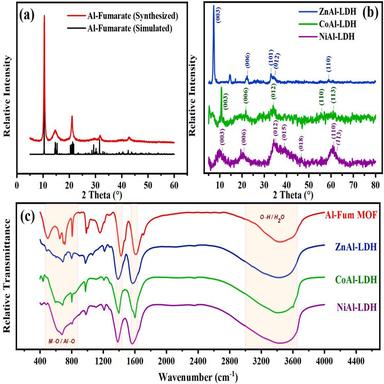
XRD patterns of a) Al-Fum MOF (synthesized and simulated), b) CoAl/NiAl/ZnAl-LDHs compared to their JCPDS card no.; c) FT-IR spectra of all synthesized materials with related functional groups.